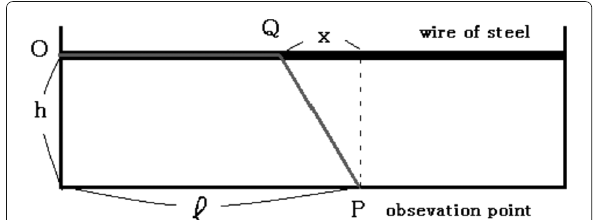
Fig. 9 A cavity of a circle in the 2-dimensional molar